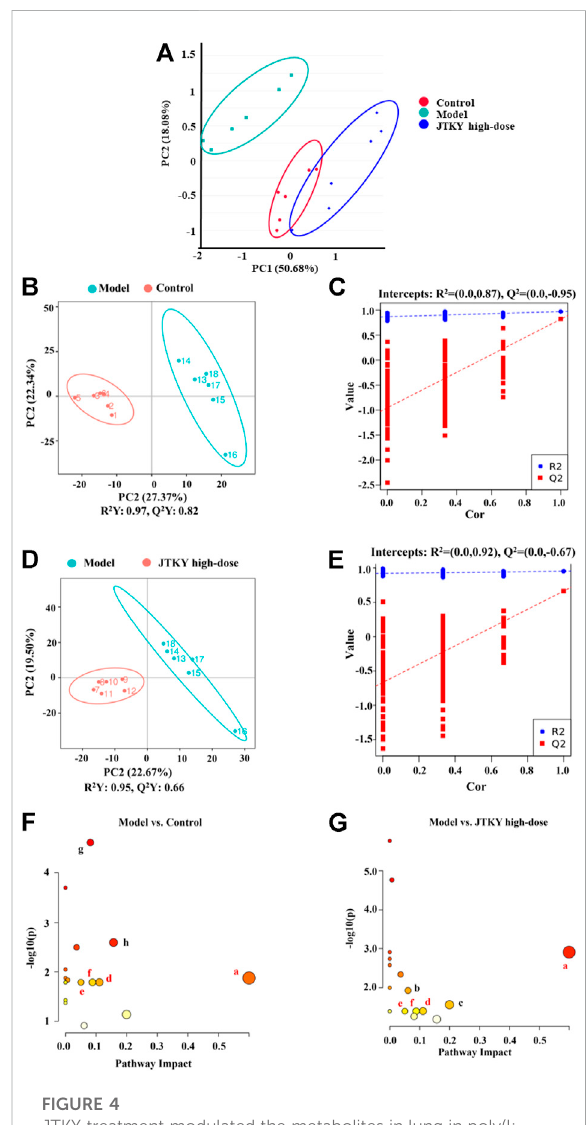
FIGURE 4 JTKY treatment modulated the metabolites in lung in poly(I: C)-induced viral pneumonia model mice. (A) Scores plots of PCA among each group. (B,C) Scores plots of PLS-DA between the control and poly(I:C) groups and the corresponding coef fi cient of loading plots. (D,E) Scores plots of PLS-DA between the model and JTKY high-dose groups and the corresponding coef fi cient of loading plots. (F,G) Summary of pathway analysis between control and poly(I:C) groups (F) and between model and JTKY high-dose groups (G) , the sames pathways were written in red. a Synthesis and degradation of ketone bodies; b Arginine and proline metabolism; c Biotin metabolism; d Butanoate metabolism; e Alanine, aspartate and glutamate metabolism; f Citrate cycle (TCA cycle); g Amino sugar and nucleotide sugar metabolism; hFructoseandmannosemetabolism. Control,Poly(I: C), and JTKY high-dose groups ( n = 6 per